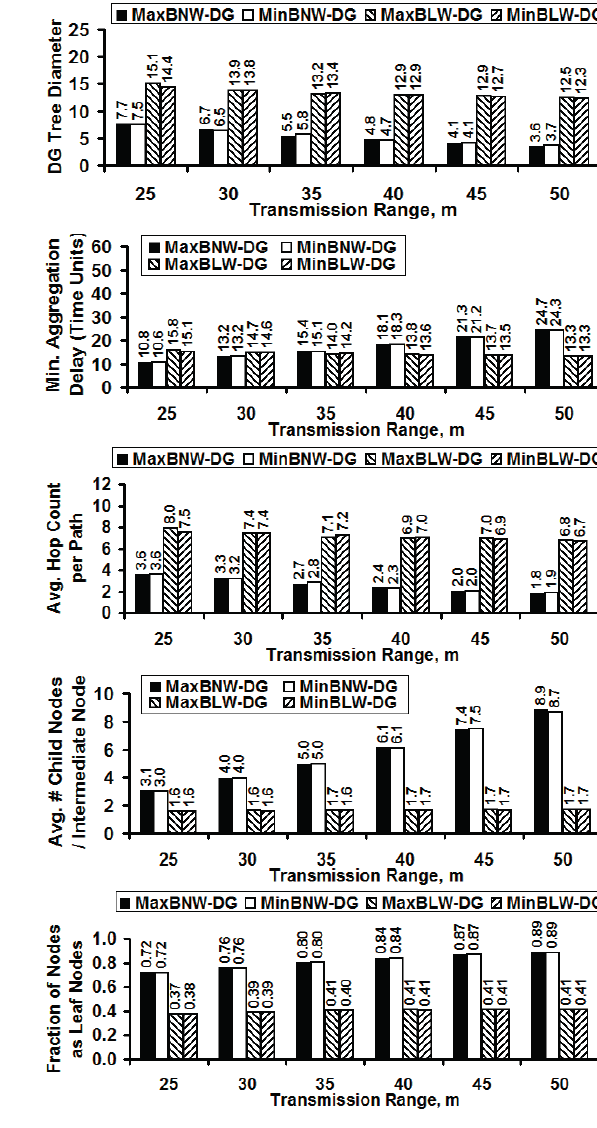
Figure 2. Performance of the Max/Min Bottleneck Node Weight and Link Weight-based DG